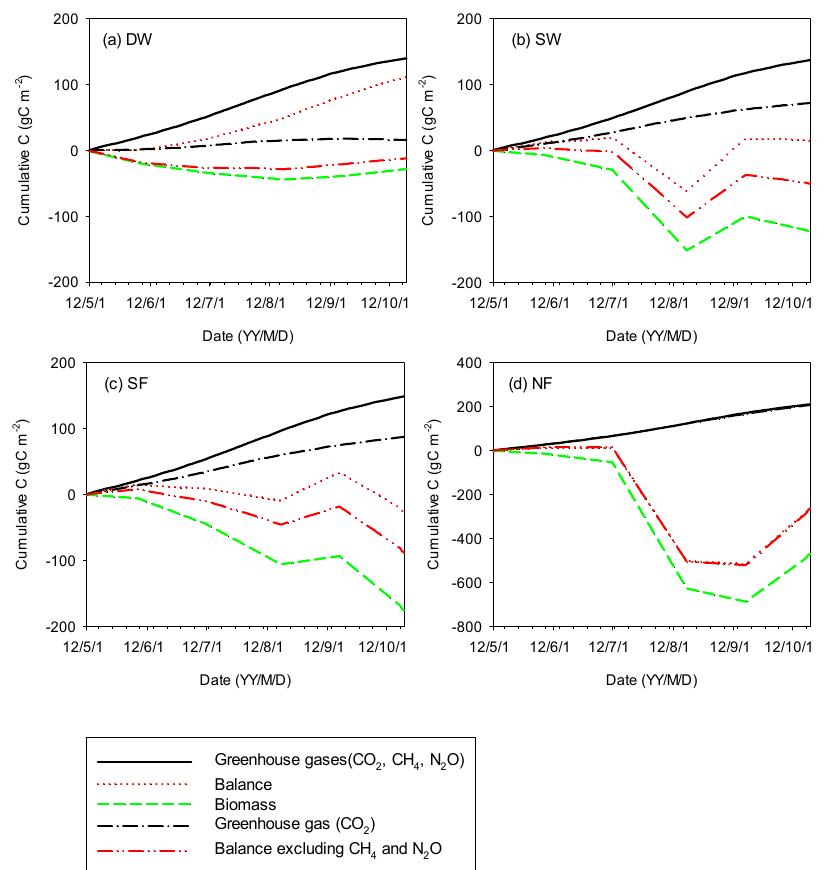
Figure 4. Cumulative greenhouse gas fluxes, biomass and the balance of the growing season. Subfigures show the cumulative greenhouse gas fluxes, biomass and the balance of site DW ( a ), SW ( b ), SF ( c ) and NF ( d ) respectively. Fluxes of CH 4 and N 2 O were converted by multiplying by Global Warming Potential. Balance was the difference in terms of C-equivalent between greenhouse gases emission and biomass. Balance excludes CH 4 and N 2 O was the difference in terms of C-equivalent between CO 2 emission and biomass. Positive values indicate C loss while negative values indicate C gain.